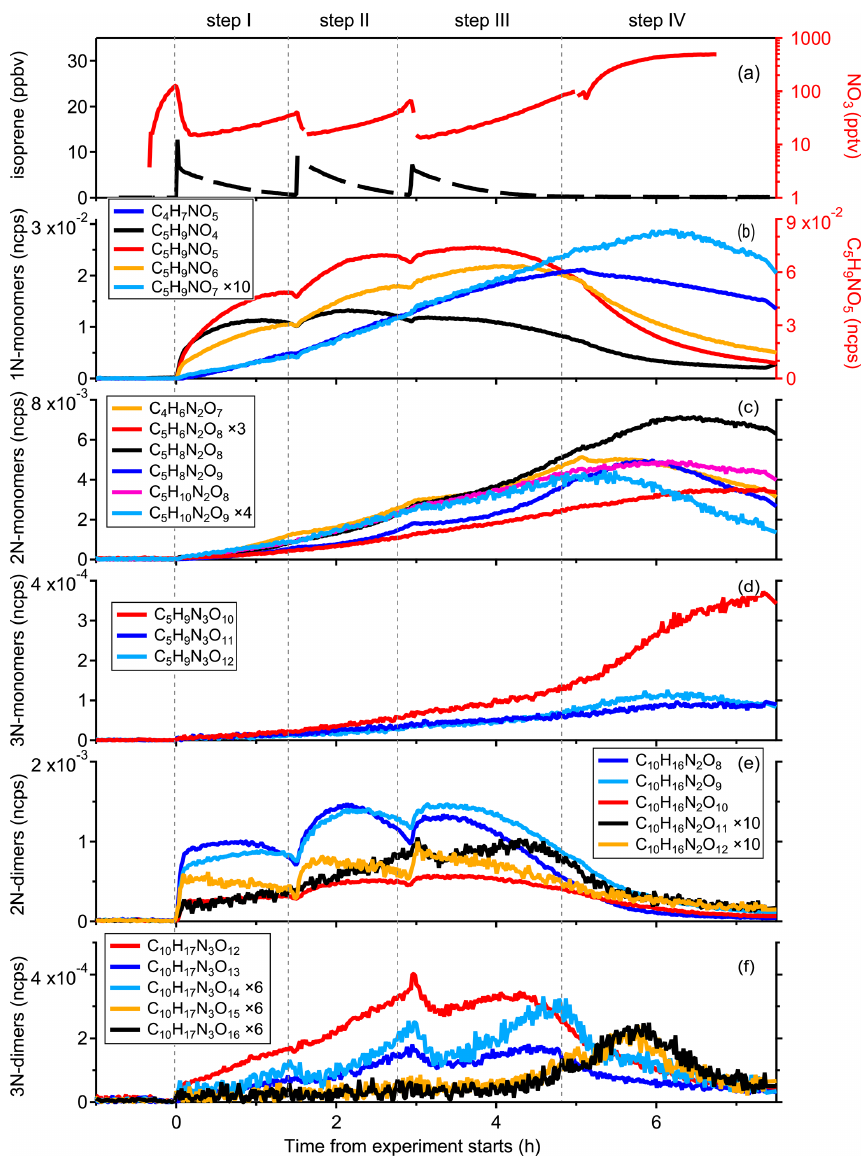
Figure 5. Time evolution of selected gas-phase compounds measured during the isoprene – NO 3 experiment on 8 August 2018. (a) Time series of O 3 , NO 2 , NO 3 , and isoprene. (b) – (f) Time evolution of major 1N-monomers (C 5 H 9 NO 4 − 7 and C 4 H 7 NO 5 ), 2N- monomers (C 4 H 6 N 2 O 7 , C 5 H 6 N 2 O 8 , and C 5 H 8 , 10 N 2 O 8 , 9 ), 3N-monomers (C 5 H 9 N 3 O 10 − 12 ), 2N-dimers (C 10 H 16 N 2 O 8 − 12 ), and 3N- dimers (C 10 H 17 N 3 O 12 − 16